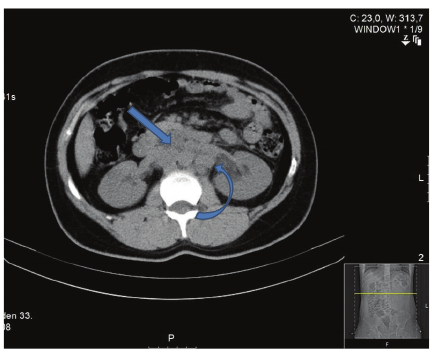
Figure 2: Para-aortic extensive lymphadenopathy in abdominal CT.